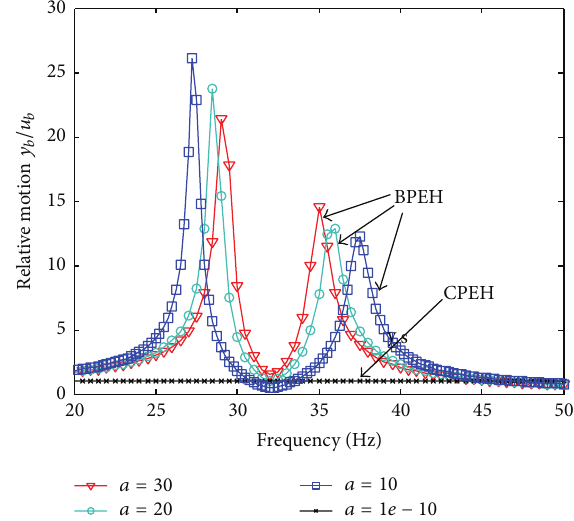
Figure 5: Relative displacement 𝑦 𝑏 with various 𝑎 when 𝑔 = 1 and Ω 𝑅 L = 1 k